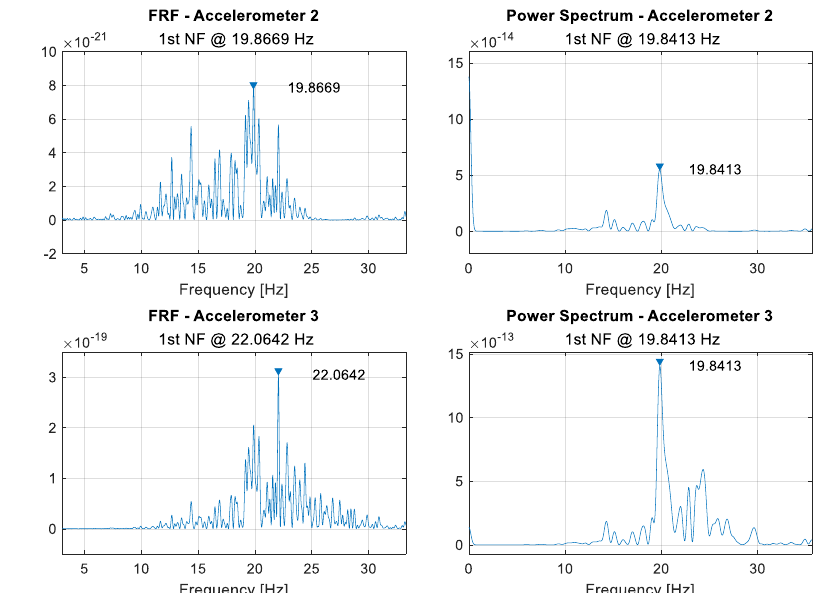
Figure A3. Oscilloscope measurement: Fully fixed boundary.